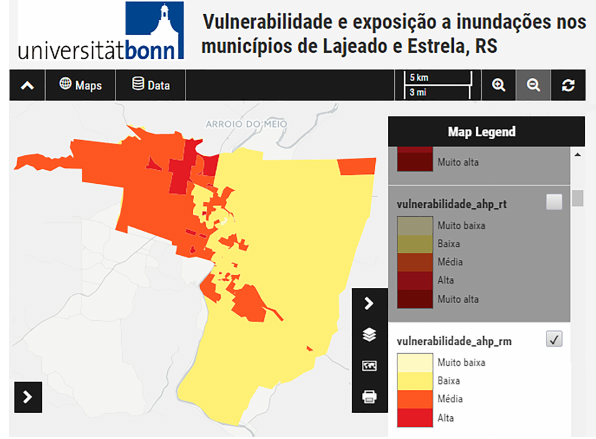
Figure 9. Web GIS platform with the 22 individual vulnerability maps created by the experts that participated in the AHP and ANP workshops.